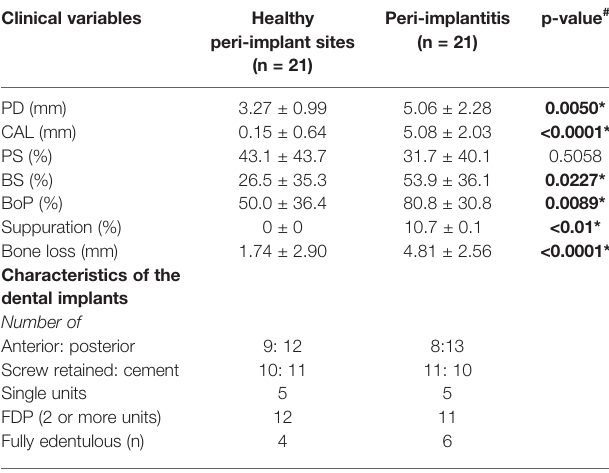
TABLE 1 | Mean (± SD) clinical parameters for monitoring peri-implant conditions, strati fi ed per group. Clinical variables